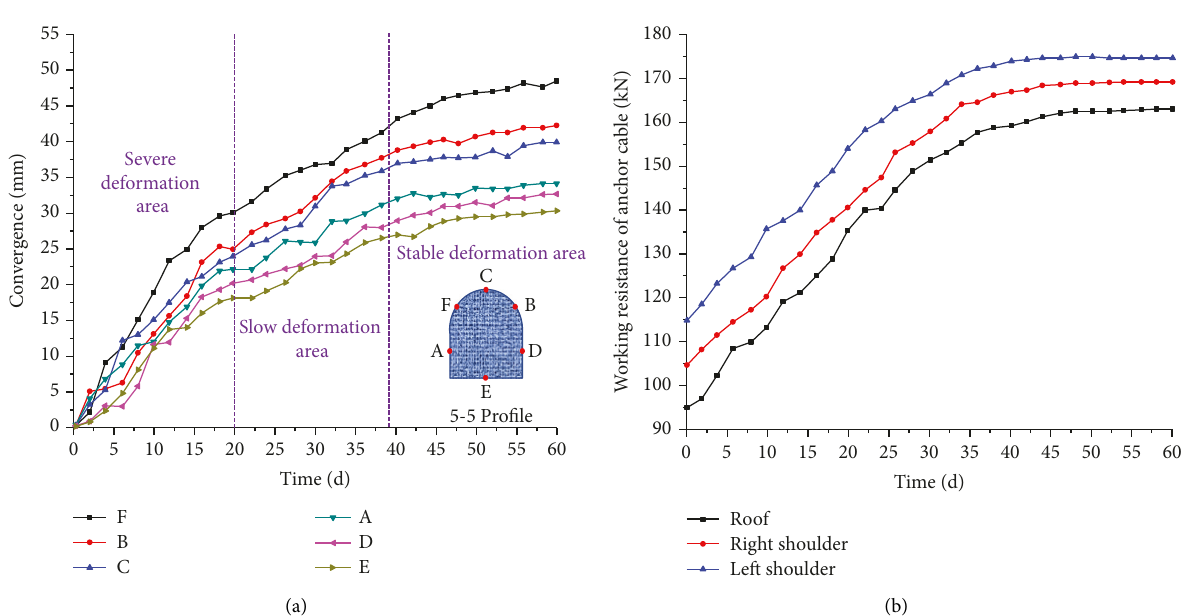
Figure 15: Spatial stereogram of support scheme.